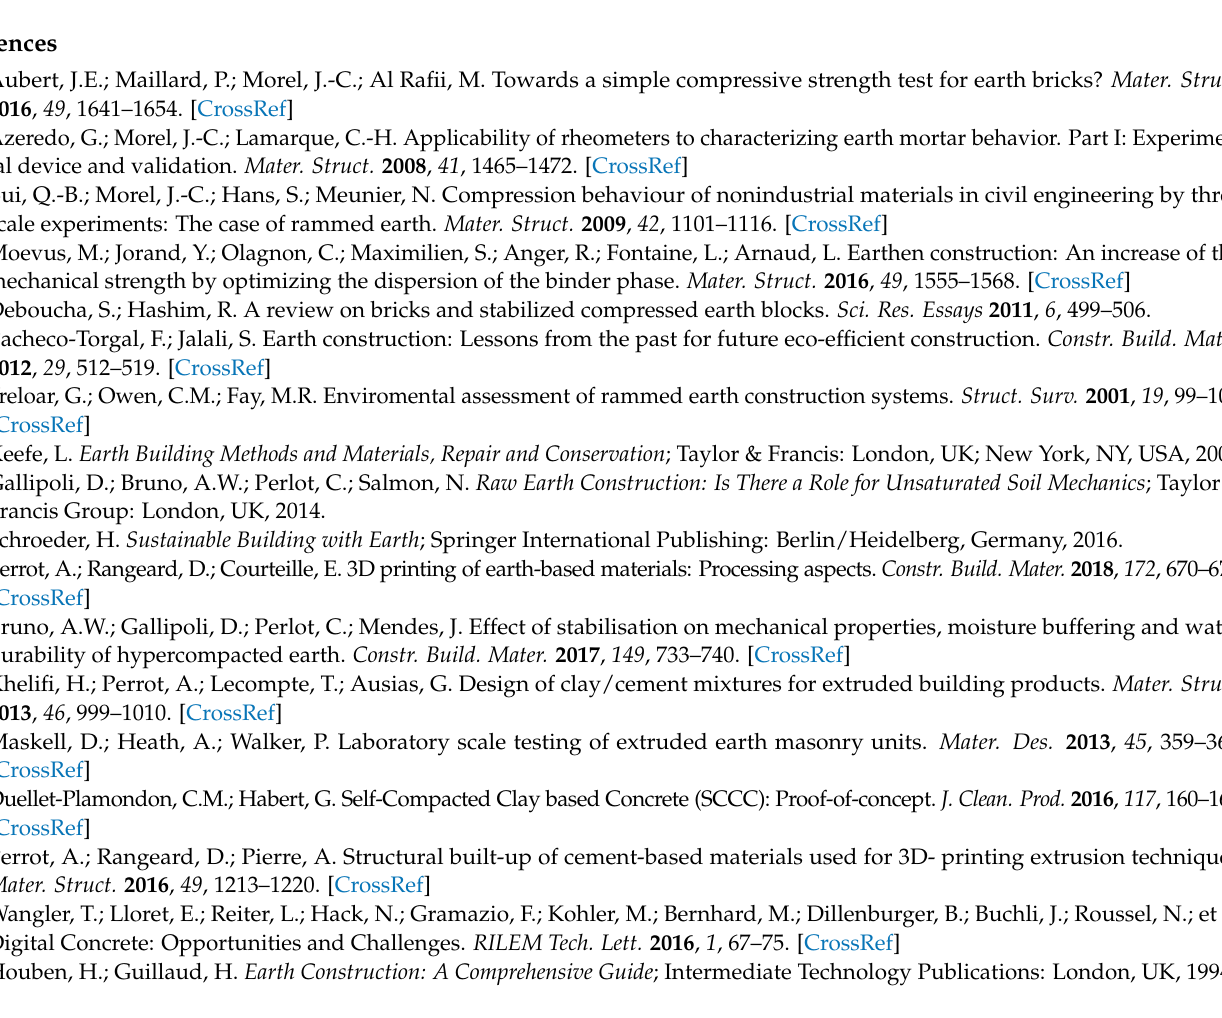
Table S1: description of the components of the LT